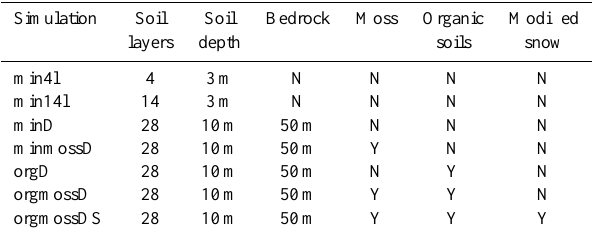
Figure 2. Upper plot: land-cover map using data from Euskirchen et al. (2007). “Shrub tundra” includes prostrate, dwarf shrub and low shrub tundra, and “boreal forest” includes boreal evergreen needleleaf and boreal broadleaf deciduous. Lower plot: mean moss cover simulated in JULES for the year 2000, from orgmossD his- torical simulation (see Table 2). Table 2. List of JULES simulations carried